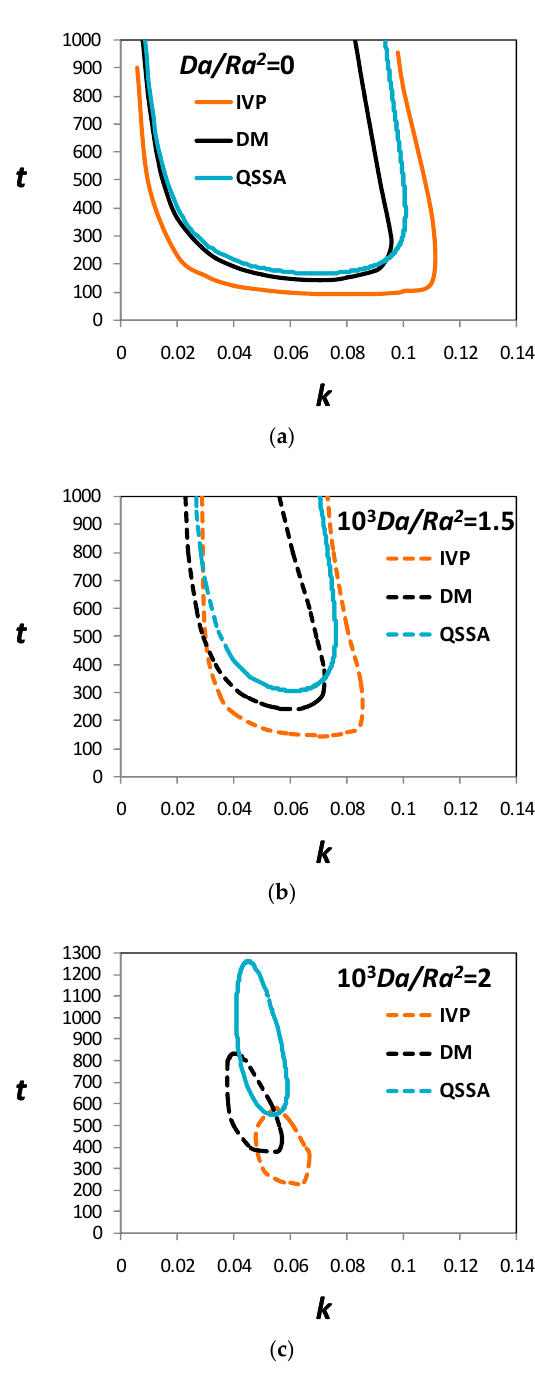
Figure 7. Comparison of neutral stability curves obtained using an initial-value problem approach (IVP), the dominant mode analysis (DM), and the quasi-steady state assumption (QSSA) method for ( a ) Da / Ra 2 = 0; ( b ) Da / Ra 2 = 1.5 × 10 − 3 ; and ( c ) Da / Ra 2 = 2 × 10 − 3